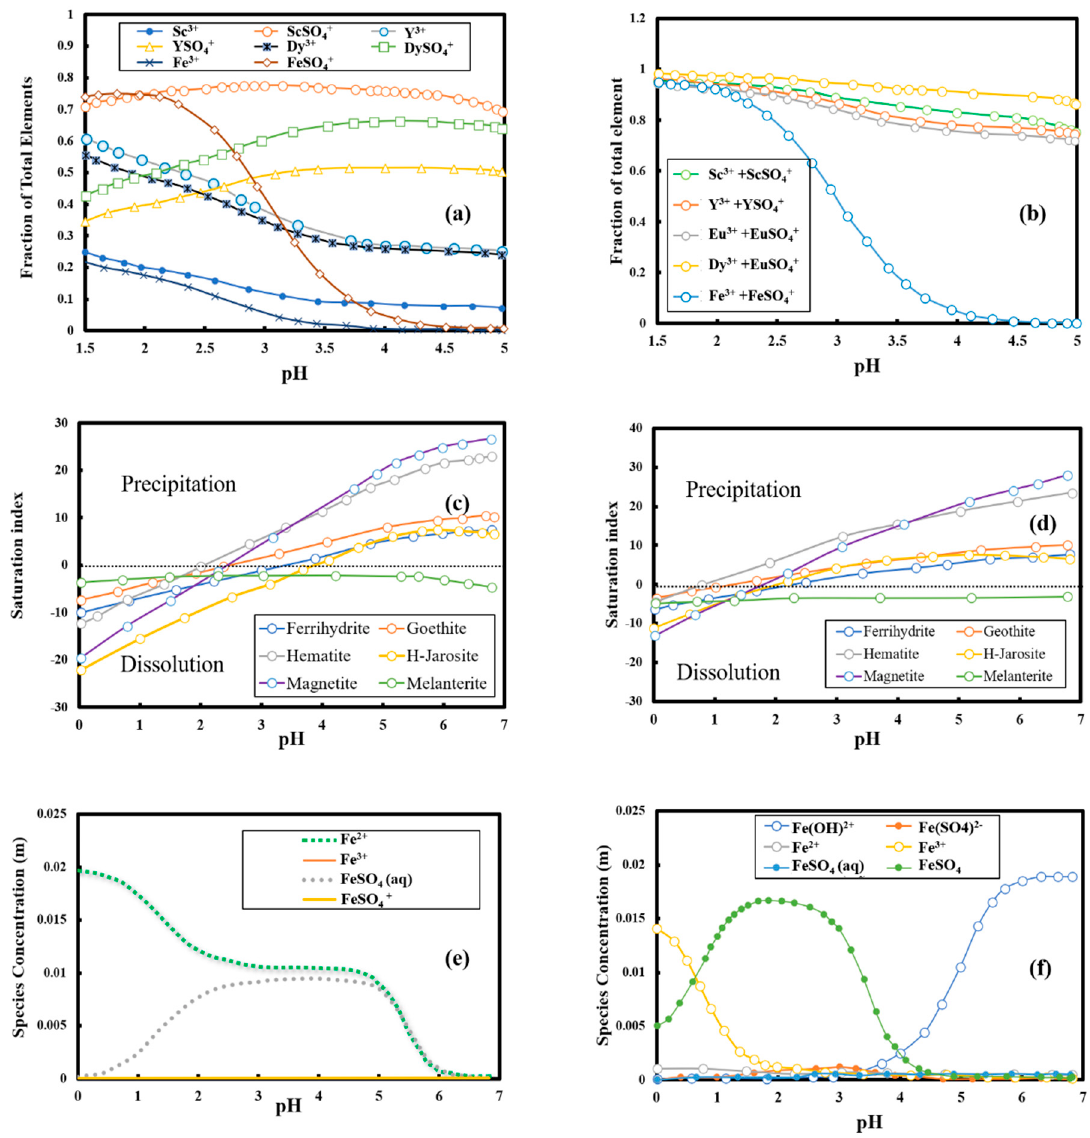
Figure 4. Visual Minteq calculation for speciation and concentrations: ( a ) speciation as a function of pH based on 20 g/L ferric sulfate heptahydrate with rare earth element concentrations of approximately 10 ppm, ( b ) soluble sum of sulfate and metal ion fractions as a function of pH based on 20 g/L ferric sulfate heptahydrate with rare earth element concentrations of approximately 10 ppm, ( c ) comparison of saturation index values, which indicate precipitate formation is feasible if above zero, as a function of pH for a solution containing 2 g/L of iron as iron sulfate (50% ferric iron and 50% ferrous iron), ( d ) comparison of saturation index values, which indicate precipitate formation is feasible if above zero, as a function of pH for a solution containing 2 g/L of iron as iron sulfate (94% ferric iron and 6% ferrous iron), ( e ) comparison of species solution concentrations as a function of pH for a solution containing 2 g/L of iron as iron sulfate (6% ferric iron and 94% ferrous iron), ( f ) comparison of species solution concentrations as a function of pH for a solution containing 2 g/L of iron as iron sulfate (94% ferric iron and 6% ferrous iron). (Visual Minteq 3.1 calculations).